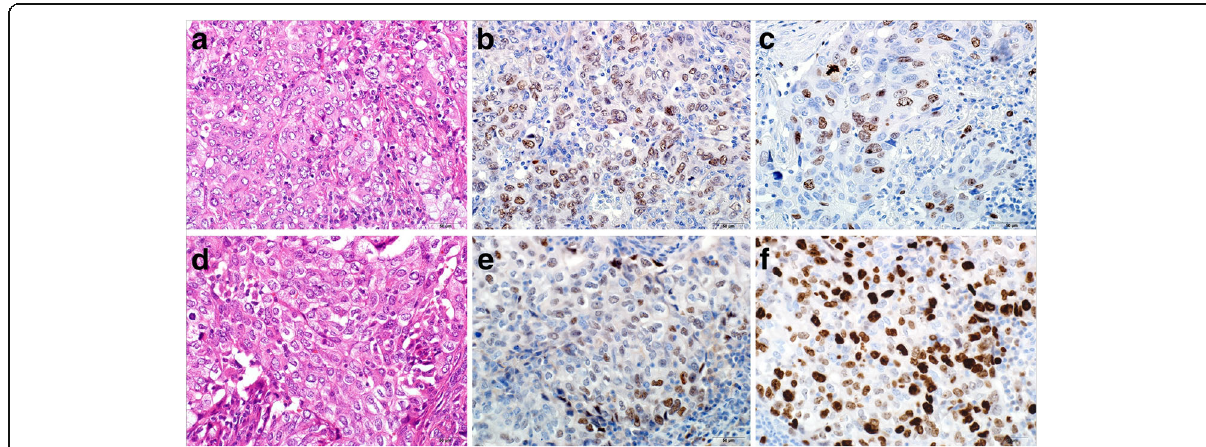
Fig. 6 The upper images showing higher magnificent microscopic images of the primary tumor in the right upper lobe wedgely resected 13 years ago. The lower images showing those of the cut-end lesion in the residual right upper lobe. From left to right, hematoxylin and eosin staining ( a , d ) and immunostaining for p53 ( b , e ) and Ki-67 ( c , f